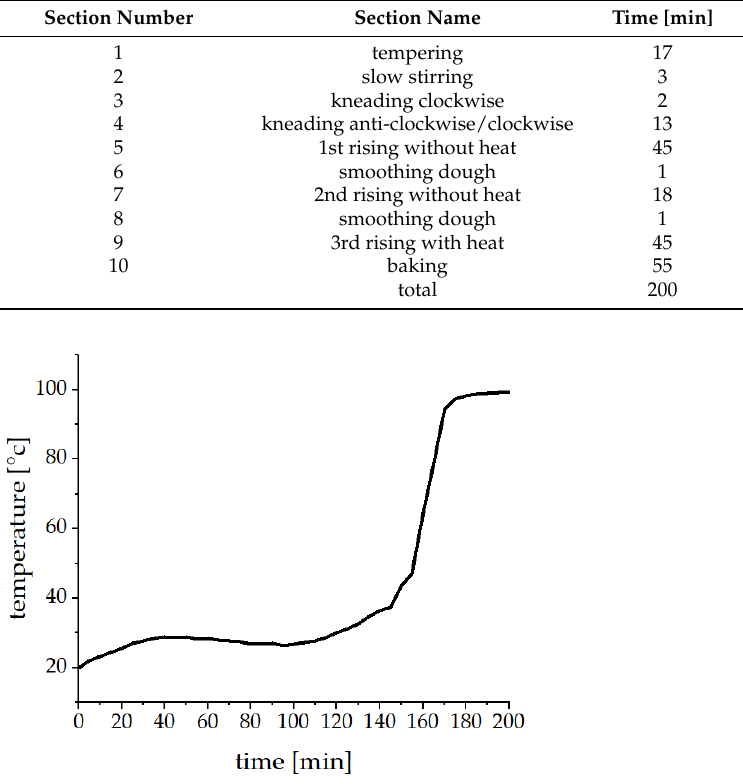
Table 1. Baking program of the UNOLD Backmeister ® extra Modell 65811.